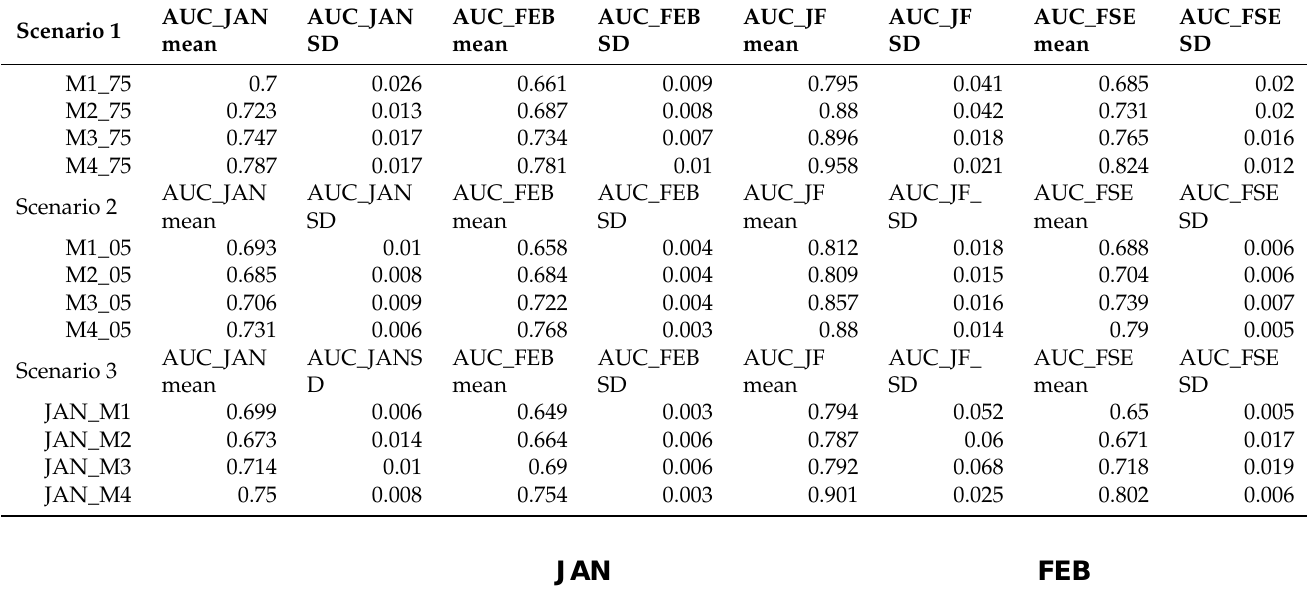
Table 8. AUC mean and standard deviation (SD) calculated for the four models and datasets, with the three validation scenarios (Scenario 1: test rate 25%; Scenario 2: test rate: 95%; Scenario 3: 5-fold spatial CV).